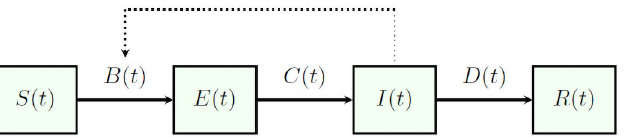
Fig 2. Representation of SEIR-model. Dynamics of the susceptible ( S ( t )), exposed ( E ( t )), infectious ( I ( t )) and recovered ( R ( t )) individuals. Solid arrows denote transitions between states. Dotted arrow indicates that transmission depends on the interactions between ( S ( t )) and ( I ( t